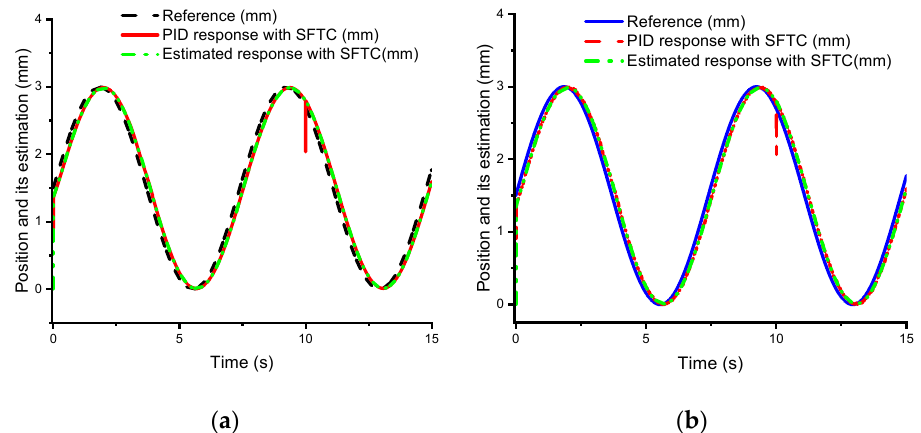
Figure 4. Sensor fault and its estimation without SFTC ( a ) disturbance d k = 0, and ( b ) disturbance d k = 0.0045 random (2, t ).